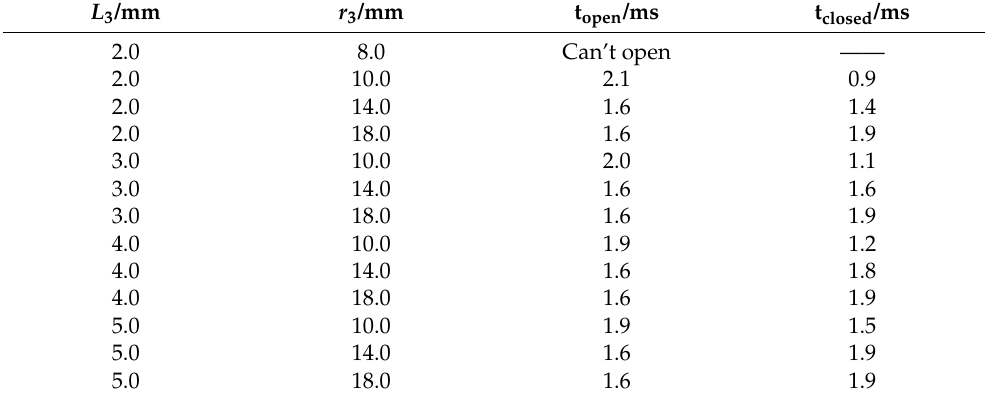
between the slotted parameters L 3 , r 3 and the dynamic response of the solenoid valve is calculated by parametrization, as shown in Table 3. Table 3. Relationship between slotting parameters and dynamic response of solenoid